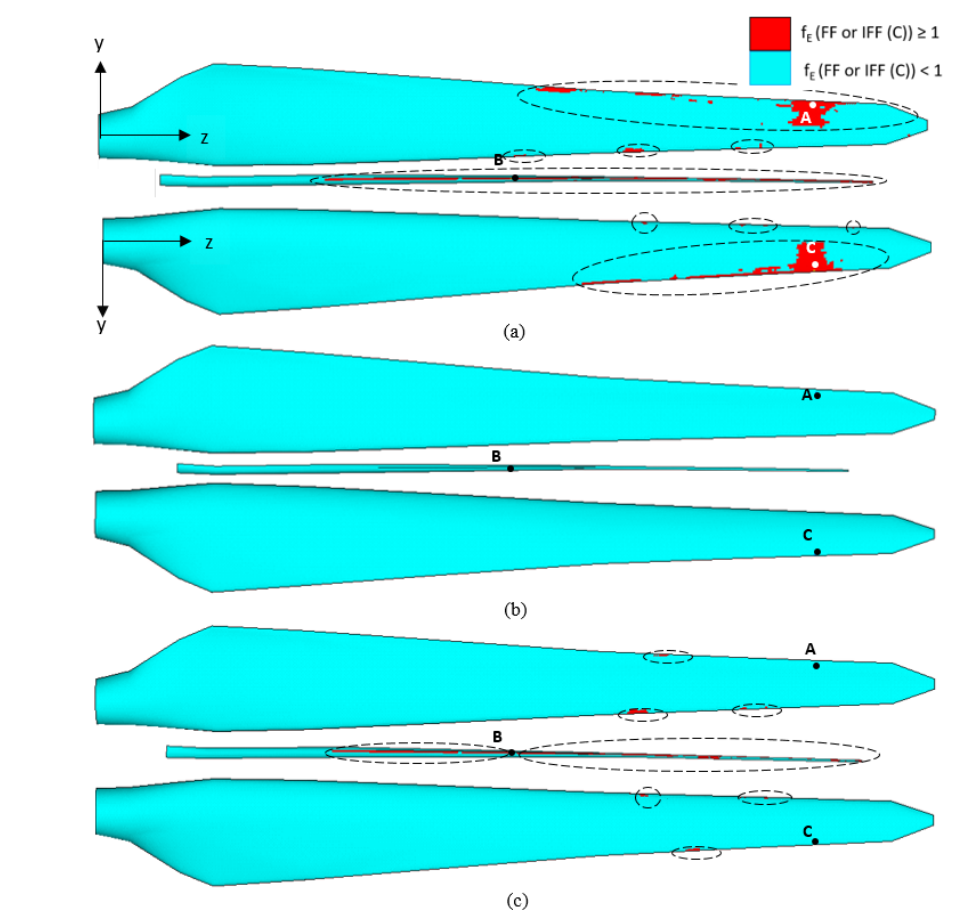
Figure 29. Element failure progression in the pressure side, internal flange and suction side of the blade (from top to bottom in a panel) under (a) extreme flapwise, (b) extreme edgewise (no element failure), and (c) combined extreme flapwise and extreme edgewise conditions in the 116% extreme loading case. Points A (48, 147, 4301) at the pressure side, B ( − 31, 152, 2224) at the internal flange and C (55, 176, 4288) at the suction side are used to interrogate the axial stress levels in the plies in Table 3 for 100% extreme